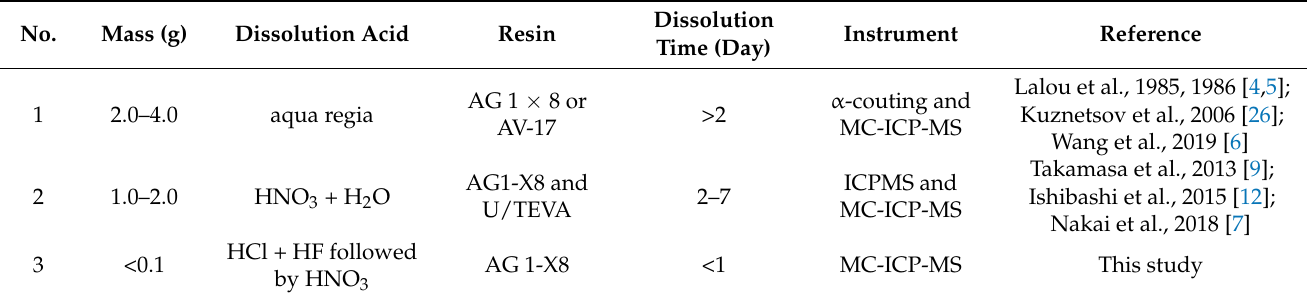
Table 4. Dissolution conditions and resin types in sulfide dating.